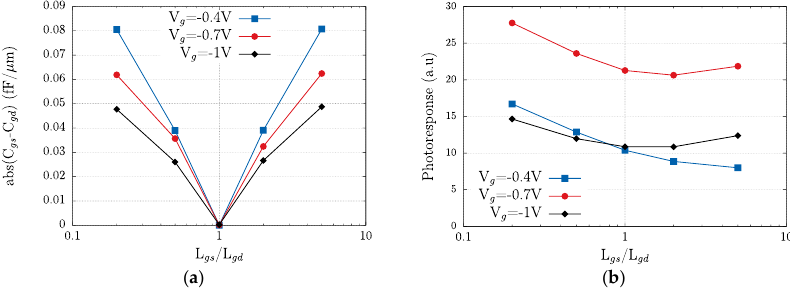
Figure 7. ( a ) Variation of the absolute difference of gate-to-source and gate-to-drain capacitances of the transistor as a function of the asymmetry factor L gs /L gd . L gs /L gd = 1 means that the gate is symmetrically disposed between source and drain contacts and L gs = L gd ; ( b ) photoresponse as a function of the asymmetry factor. Simulations were performed for three gate biases ( − 0.4, − 0.7 and − 1